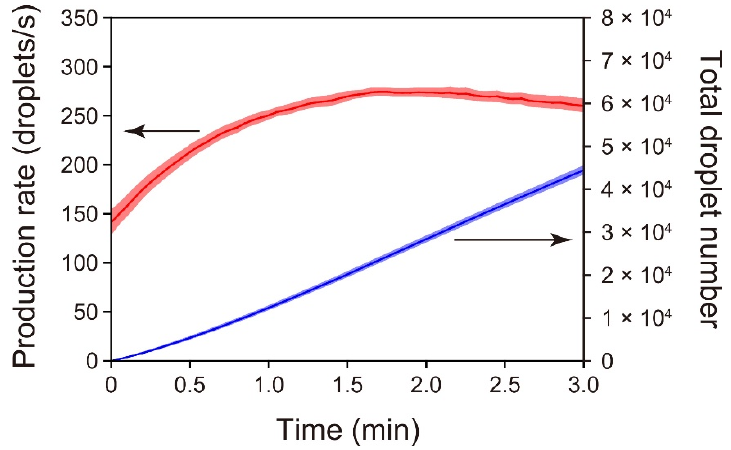
Figure 3. Changes in the rate of droplet-production over the time-course of the experiment ( n = 5) for the PMMA/PDMS microchip. The red line shows the mean droplet-production rate. The blue line shows the mean total number of droplets produced, which was calculated by integrating the production rate with respect to time. The colored, shaded areas above and below the lines represent ±1 standard error of the mean.